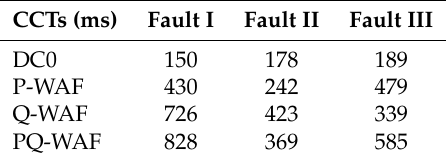
Table 2. Critical clearing times